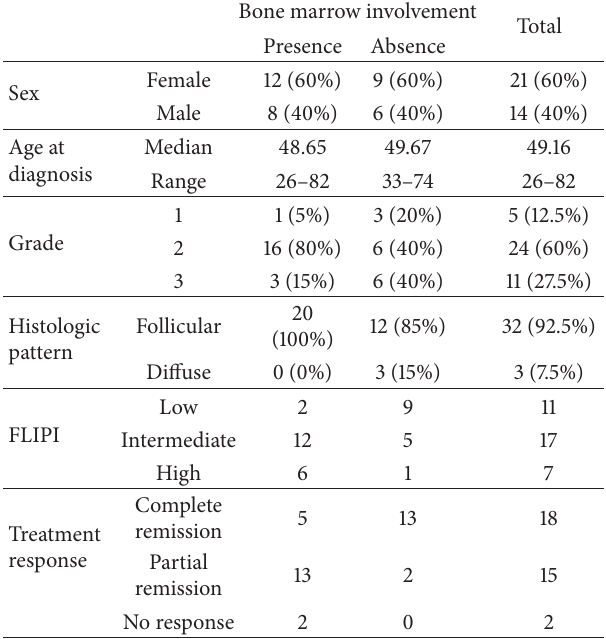
Table 1: Clinicopathological data of follicular lymphomas studied. Bone marrow